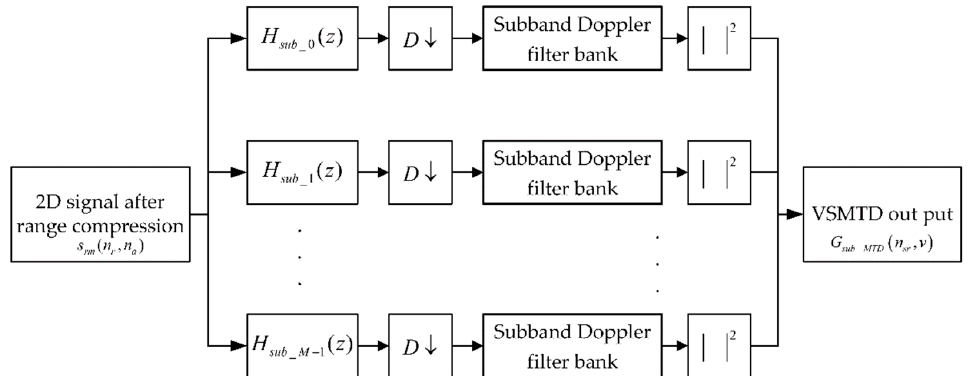
Figure 6. Subband Doppler filter bank.